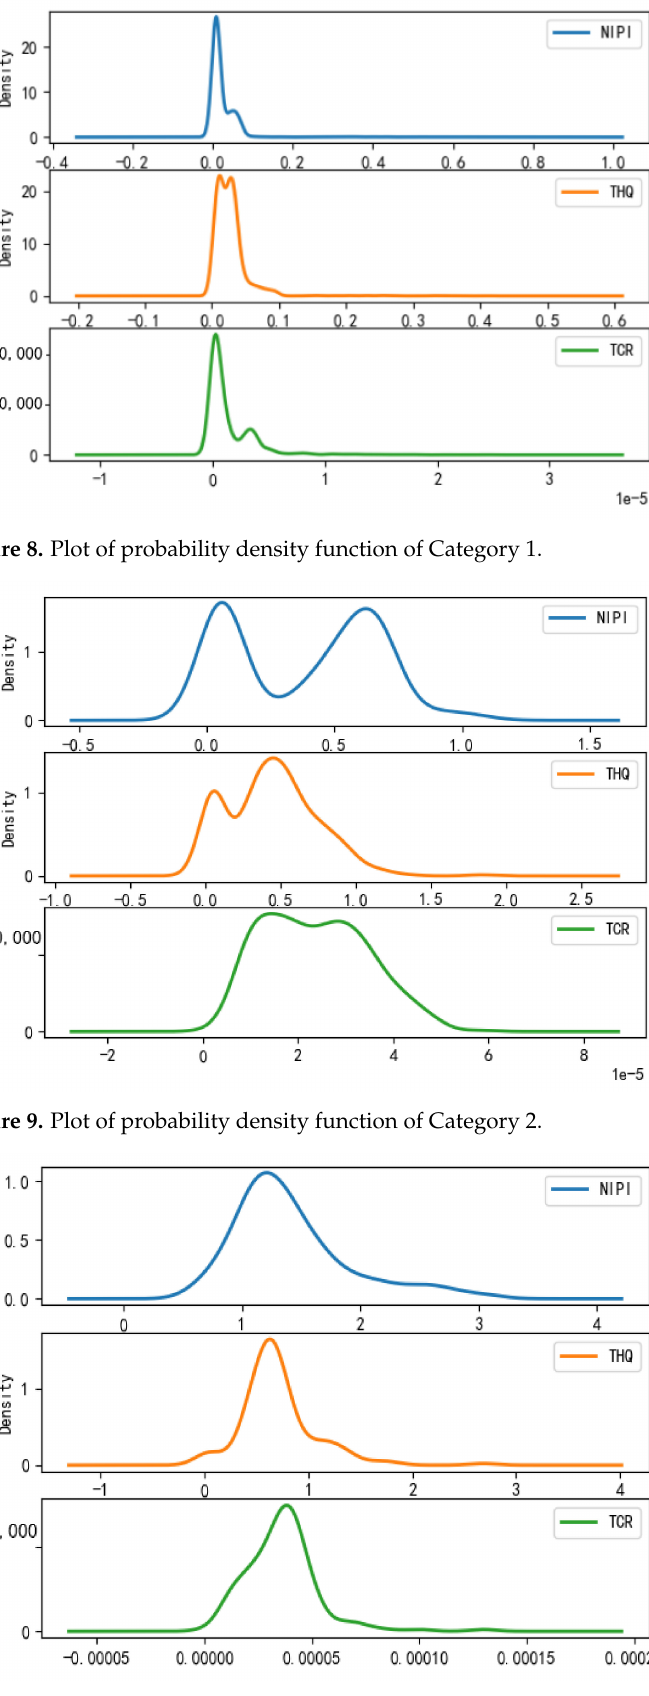
Figure 10. Plot of probability density function of Category